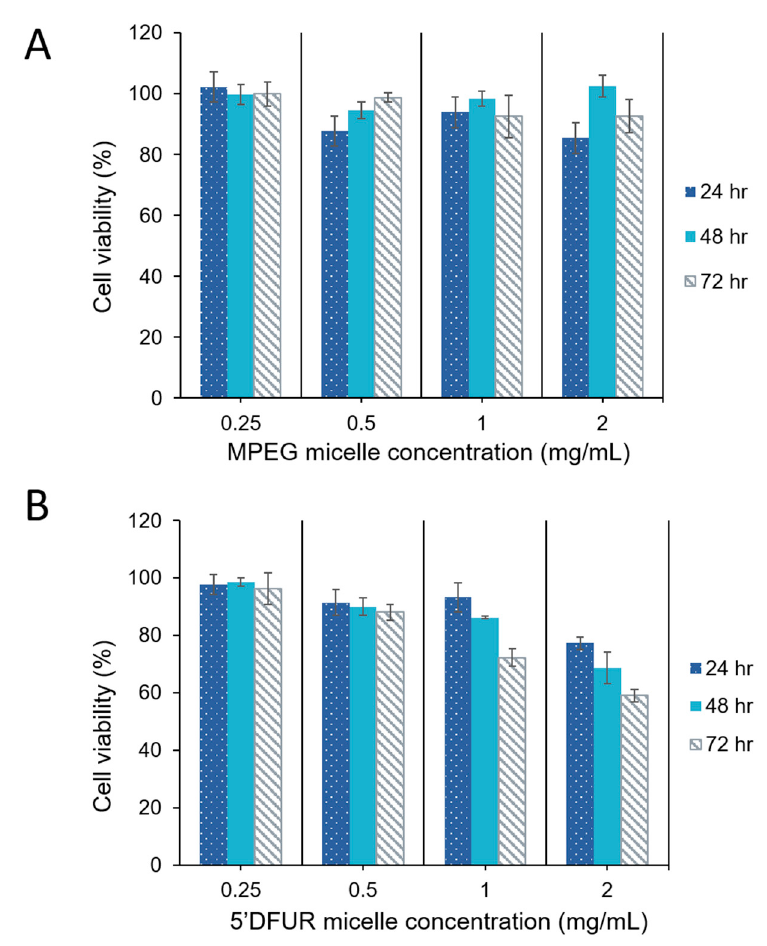
Figure 8. Cell viability of HT-29 cells after treatment with polymeric micelles for 24, 48, and 72 h. ( A ) MPEG 350 -PCL-MPEG polymeric micelles, ( B ) 5’-DFUR-PCL-MPEG polymeric micelles (mean ± SD, n = 3).